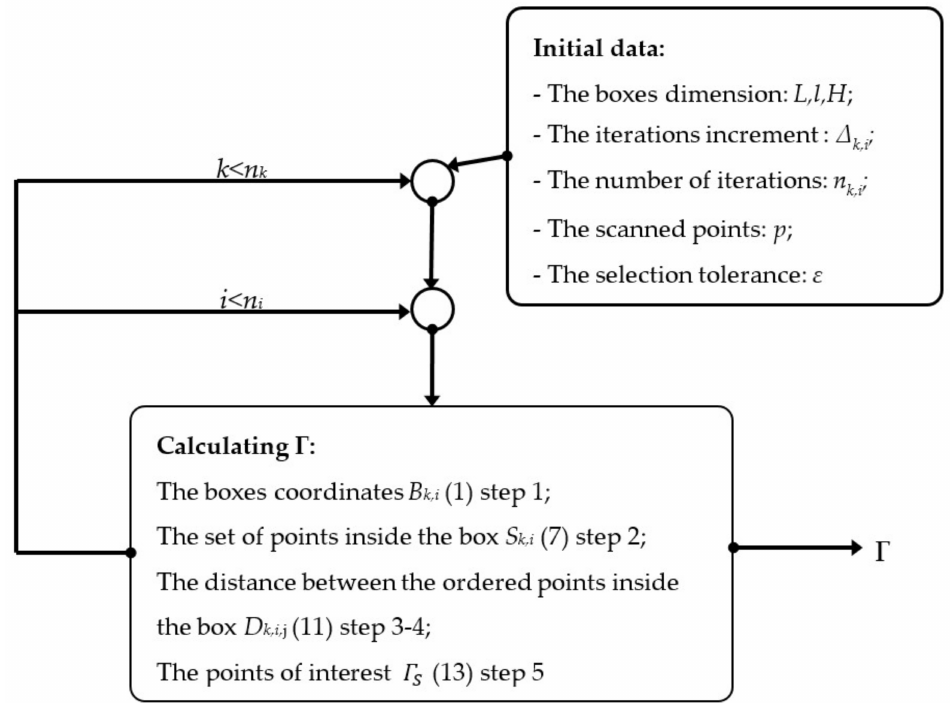
Figure 5. The proposed algorithm (star-shaped search